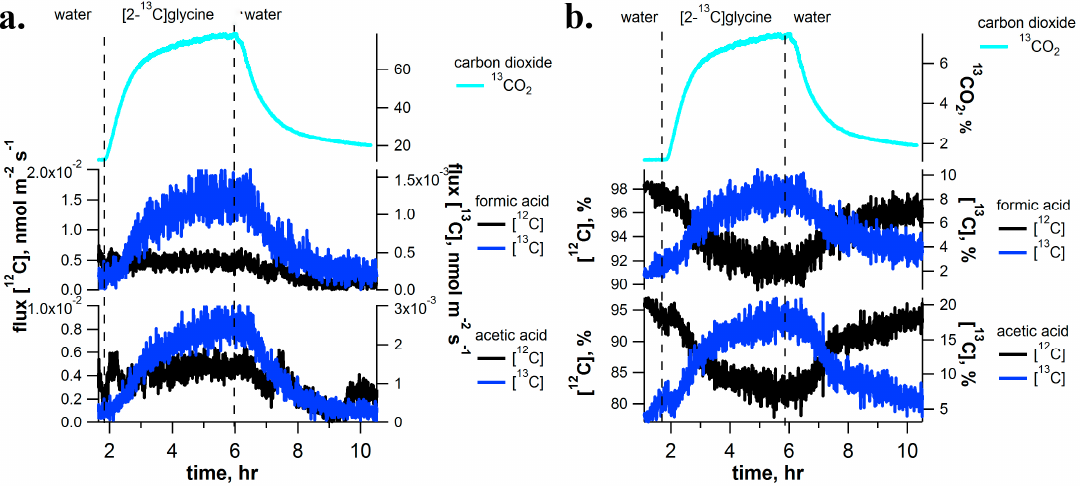
Figure 4. Example [2- 13 C]glycine pulse-chase experiment on a detached branch of I. edulis showing real-time [ 13 C]labeling and unlabeling dynamics of C 1 and C 2 volatile metabolites using PTR-MS (absolute emissions in ( a ) and relative emissions in ( b )). 13 CO 2 branch emissions are also shown based on CRDS. Vertical dashed lines indicate a rapid change of solutions delivered to the transpiration stream (i.e., water to [2- 13 C]glycine and vice verca). Note, despite a strong labeling of CO 2 emissions, significant labeling of methanol and formaldehyde emissions were not observed (data not shown).